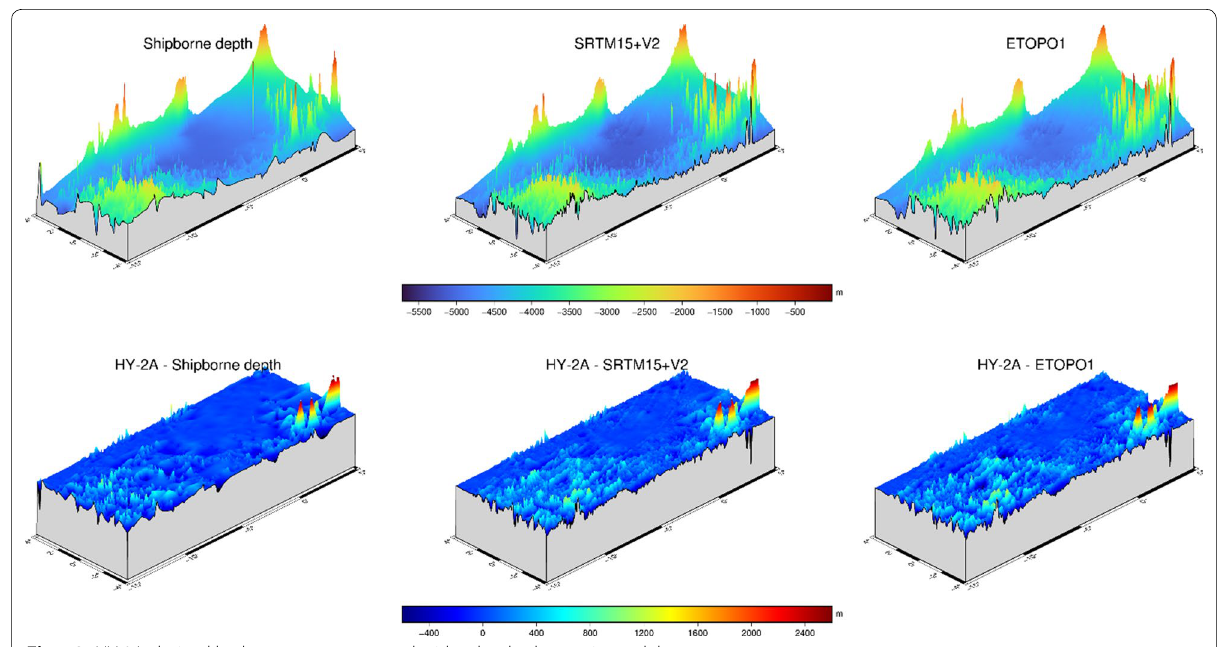
Fig. 13 HY-2A-derived bathymetry as compared with other bathymetric